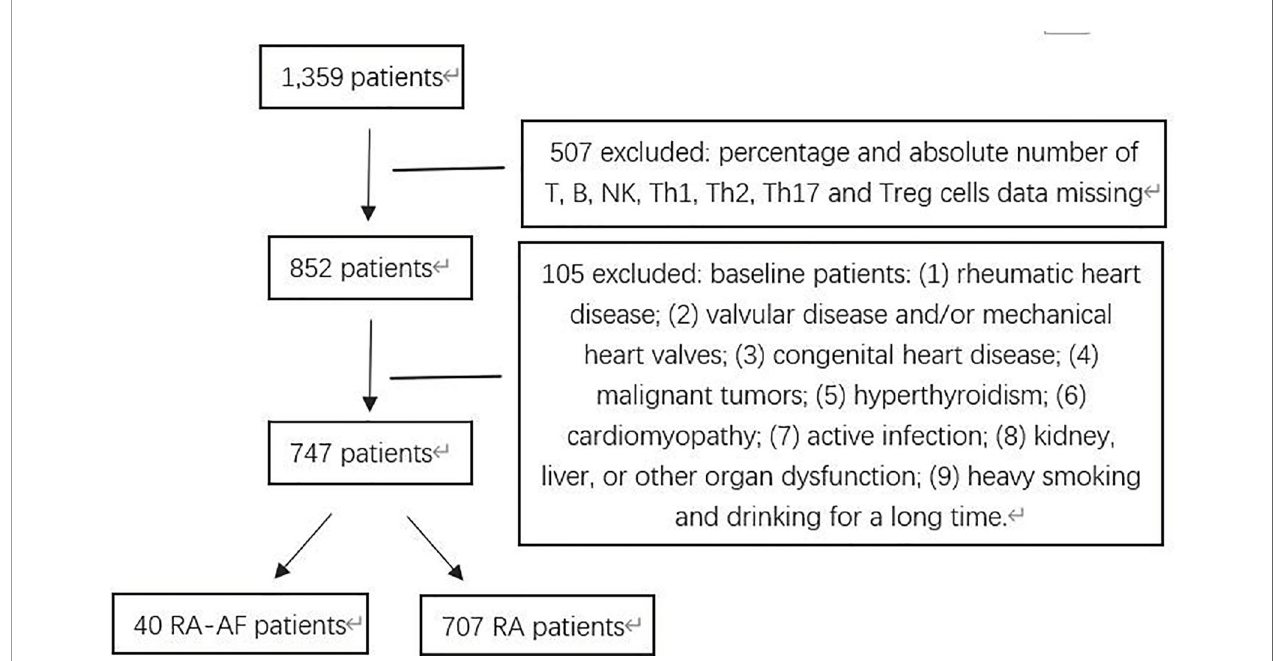
FIGURE 1 | Flowchart of patients with rheumatoid arthritis (RA) and RA presenting atrial fi brillation (AF) enrolled in this